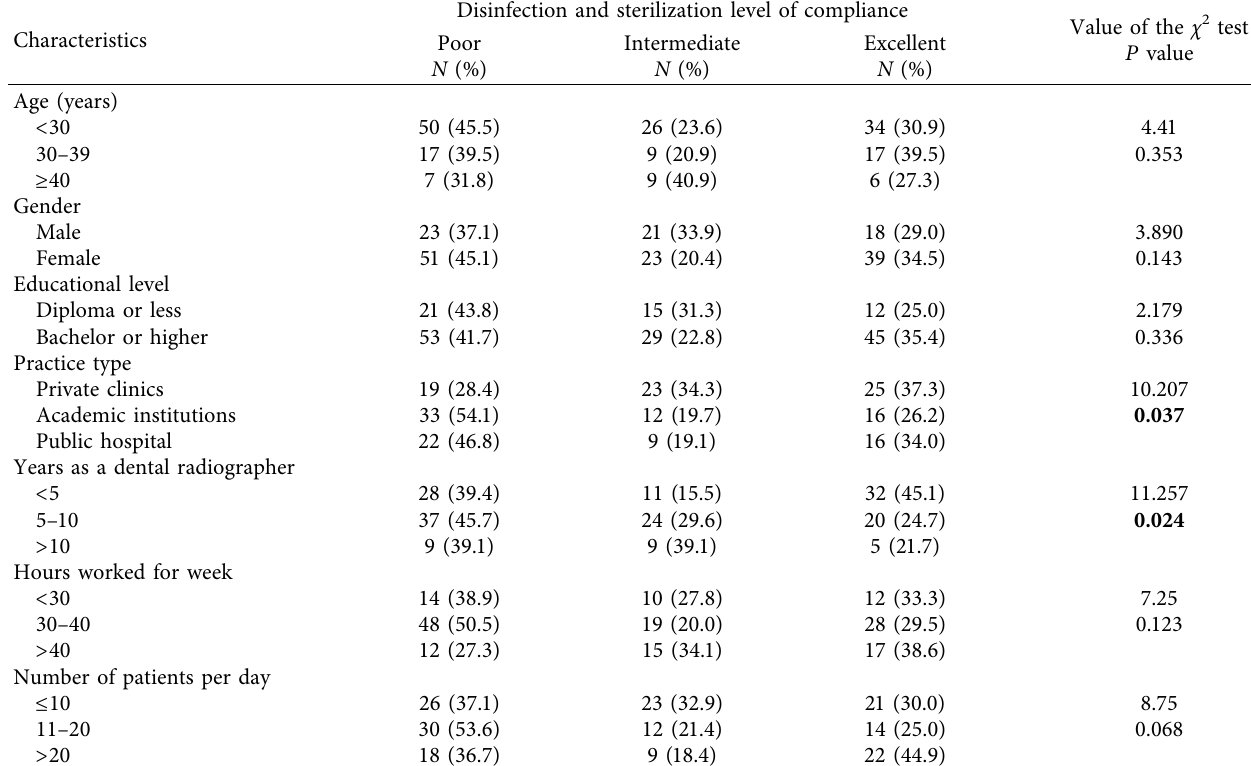
Table 6: The level of compliance with disinfection and sterilization practices ( N � 175).